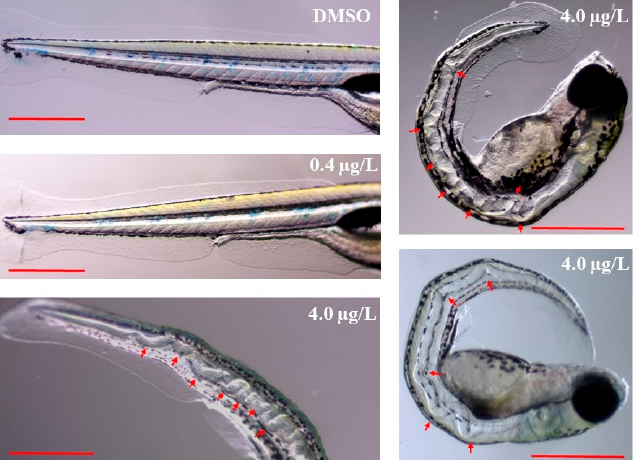
Figure 4. Representative images showing the notochord of the zebrafish at 144 hpf. Red arrows indicate the wavy distortions of notochords; Scale = 0.5 mm.